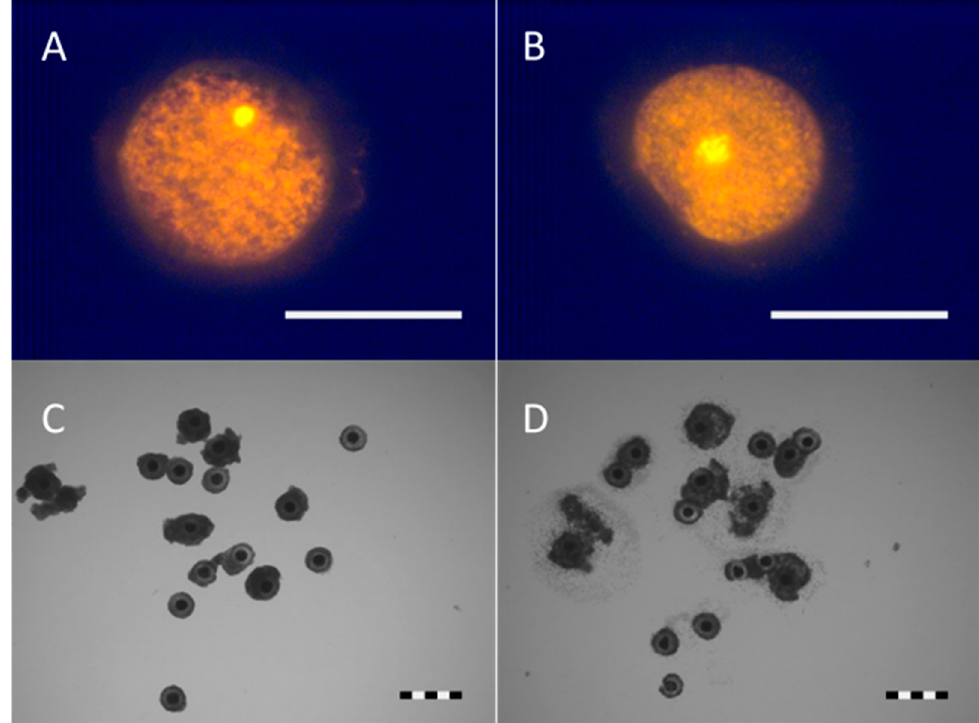
Figure 2. Oocytes stained with propidium iodide are shown on a fluorescence microscope ( A ), a GV, and ( B ) an early GVBD, scale bar = 100 µM. Oocytes frozen in titanium tubes ( C ) before and ( D ) after IVM, scale bar = 500 µM.